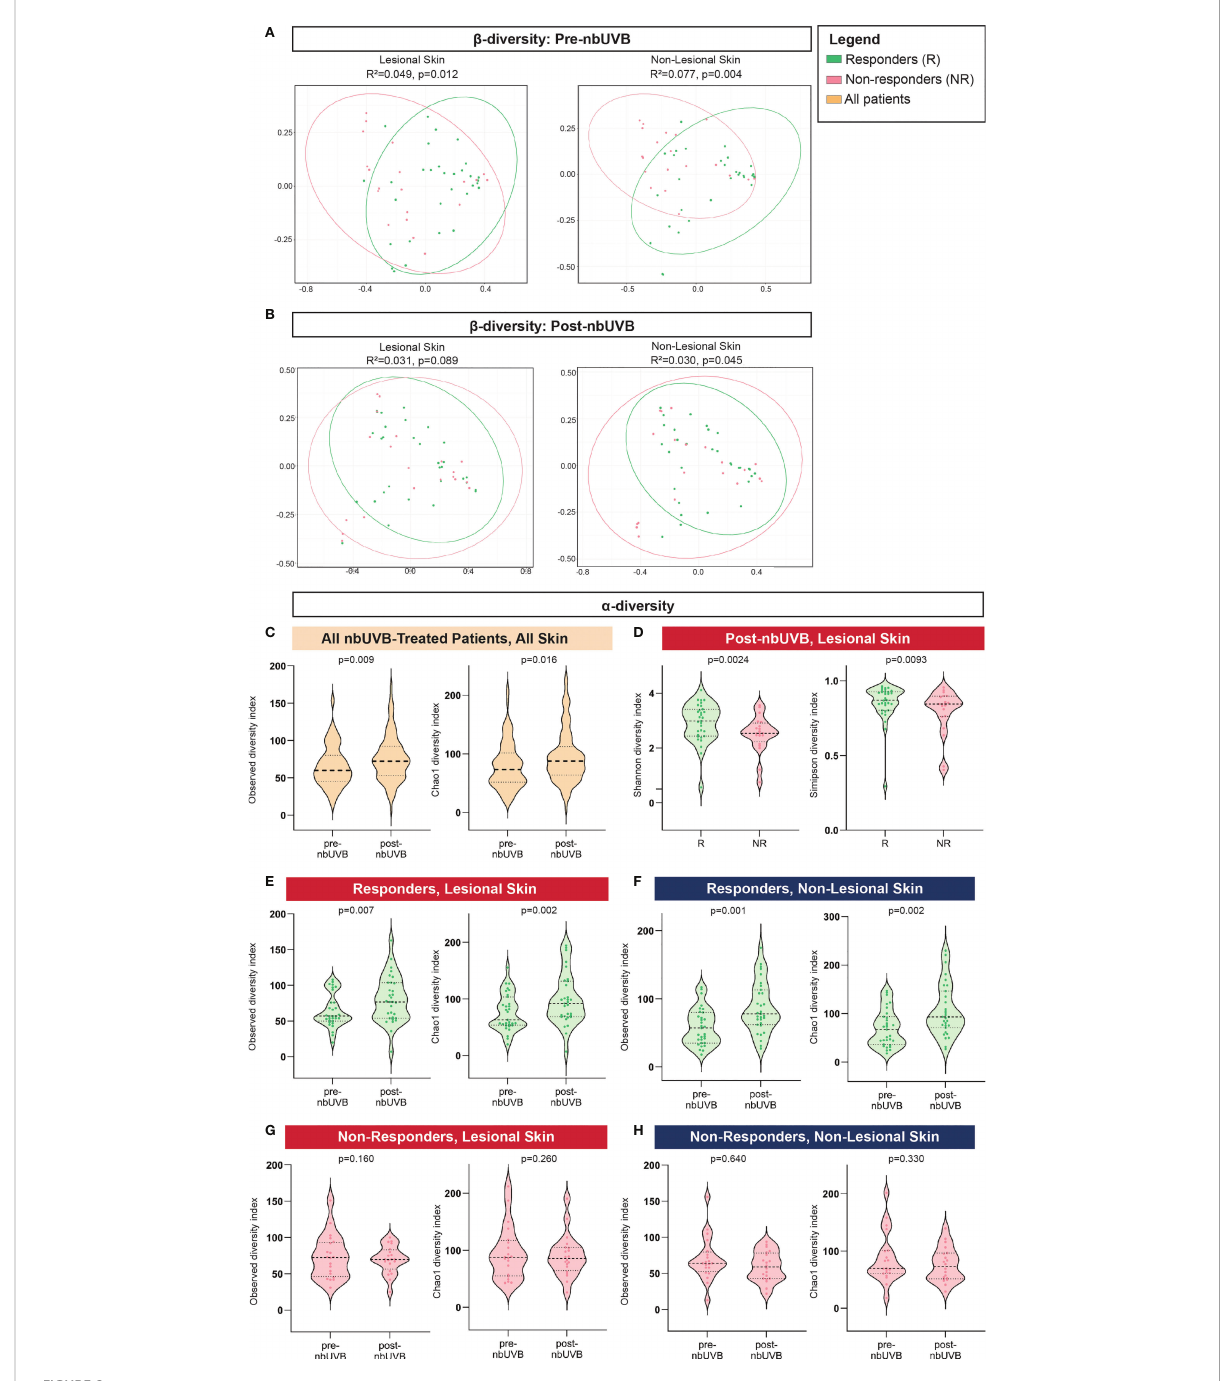
FIGURE 2 Distinct microbial communities comprise the skin microbiota of nbUVB responders and non-responders before and after nbUVB. (A) Bray-Curtis dissimilarity indices demonstrated Responder (R) and Non-Responder (NR) bacterial skin communities were distinct prior to nbUVB in lesional and non-lesional skin. (B) R versus NR post-nbUVB community differences approached signi fi cance in lesional skin, but reached signi fi cance in non-lesional skin. (C) Amongst all nbUVB-treated patients, a -diversity increased after phototherapy. (D) Following nbUVB, a -diversity of lesional skin was higher in R than NR. (E) a -diversity of R lesional skin and (F) non-lesional skin signi fi cantly increased after phototherapy. (G) No pre- versus post-nbUVB a -diversity differences were noted in NR lesional or (H) non-lesional skin. Thick dashed horizontal black lines indicate group median; thin dashed lines indicate 1 st and 3 rd